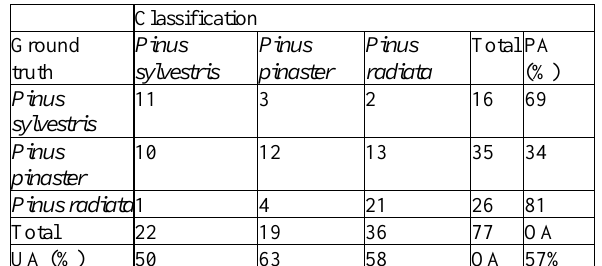
Table 9. Confusion matrix obtained for the non-filtered classification. OA (Overall Accuracy), PA (Producer’s Accuracy) and UA (User’s